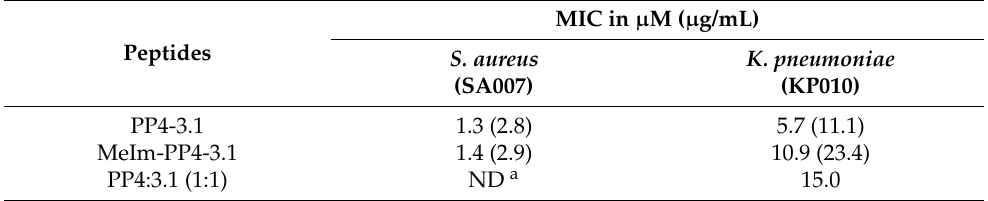
Table 3. Activity of the peptides against planktonic S. aureus and K. pneumoniae MDR clinical isolates in